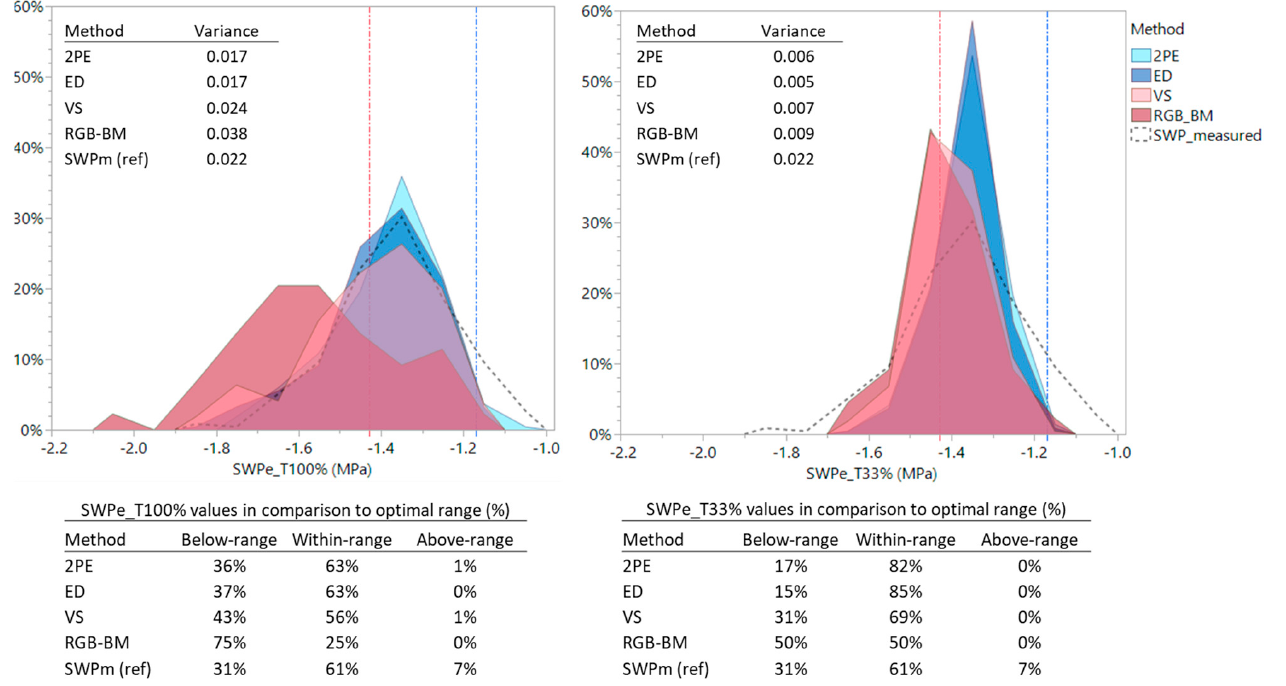
Figure 10. Histogram of percent estimated stem water potential (SWPe) (MPa) calculated using the canopy temperature data of the average 100% (SWPe_T100%) and the average of the coolest 33% (SWPe_T33%) of canopy pixels in comparison to the defined optimal SWP range for stage III: upper ( − 1.17 Mpa, blue dashed line) and lower ( − 1.43 Mpa, red dashed line) thresholds. Below-range SWP values indicate orchard stress, while above-range water status values indicate theoretical over-irrigation. The canopy extraction methods tested were 2-pixel erosion (2PE, turquoise polygon), edge detection (ED, blue polygon), vegetation segmentation (VS, pink polygon), and RGB binary masking (RGB-BM, red polygon).